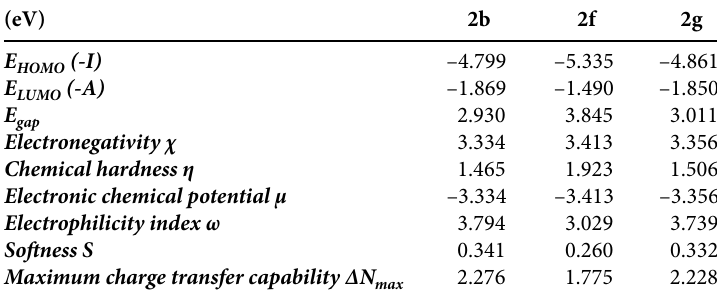
Table 3. Global descriptors of chemical reactivity of meta -cyanobenzyl substituted benzimidazolium salts.